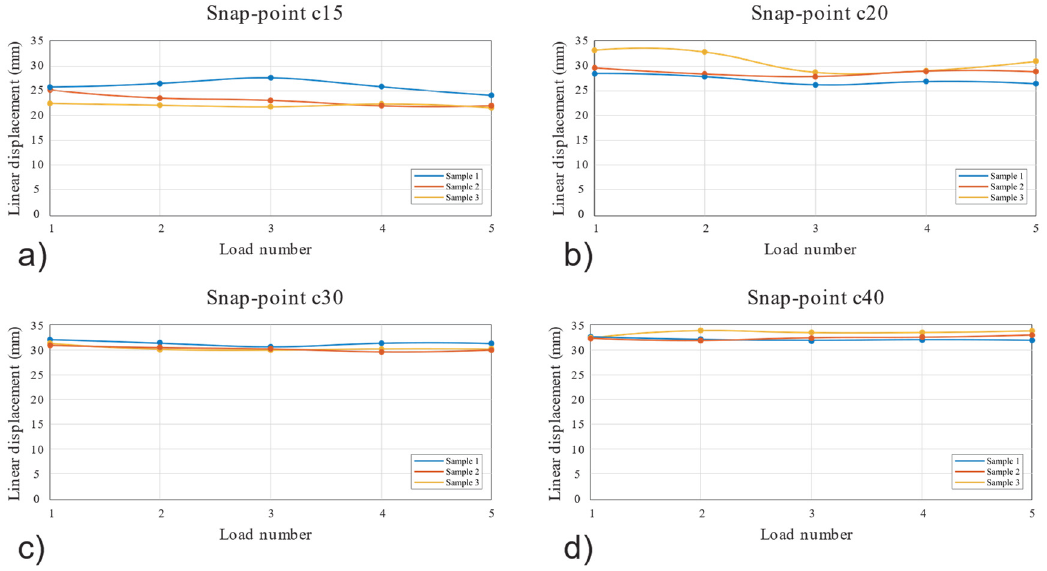
Figure 9. ( a – d ) Snap-through points in relation to the load cycle graphs. The straightness of the curves suggests that the mechanisms travel a similar linear distance before snapping-through, regardless of the load